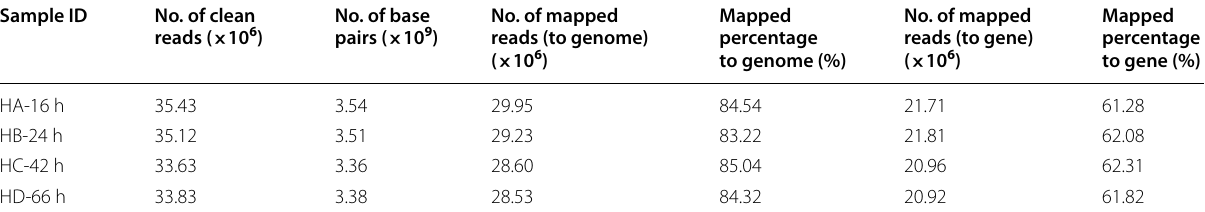
Table 1 Sequencing and assembly statistics for the 11 transcriptome data of A. niger DS03043 at four time points in the process of glucoamylase fermentation